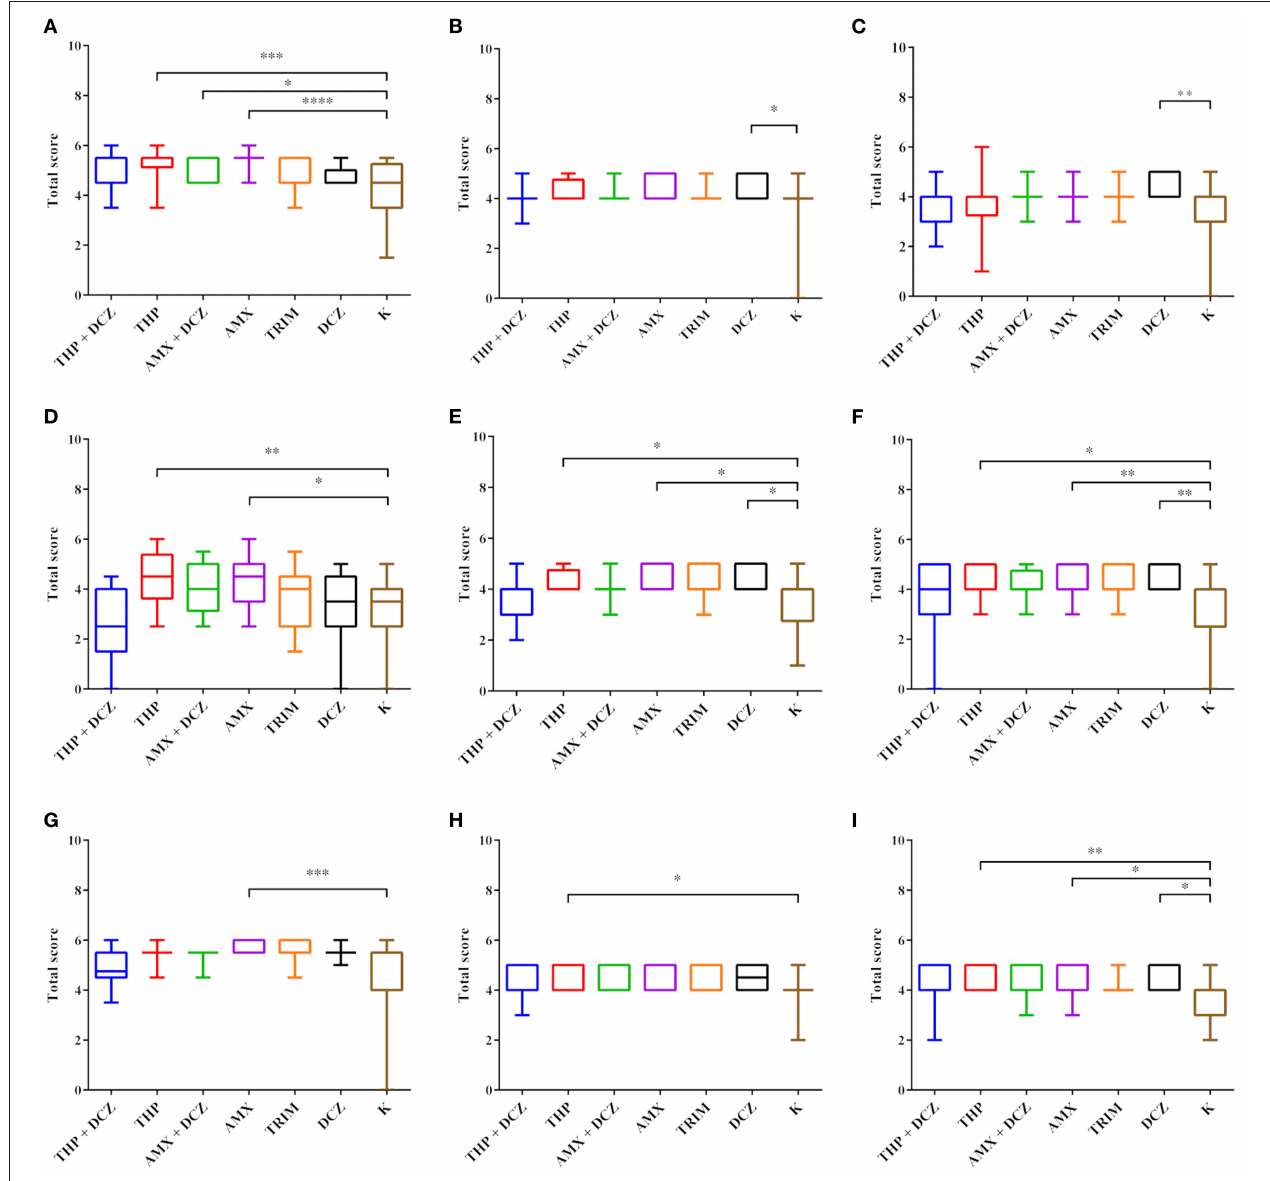
FIGURE 3 | Statistical analysis of HE scores. Box plot graphs were generated for ileum (A,D,G) , cecum (B,E,H) and colon (C,F,I) . The data for the villi total scores (A–C) , the lymphocyte score in the mucosa (B,E,H) and the lymphocyte score in the submucosa (C,F,I) are, respectively, shown. Results were considered significant with p- value < 0.05 (* p < 0.05; ** p < 0.01; *** p < 0.001; **** p <